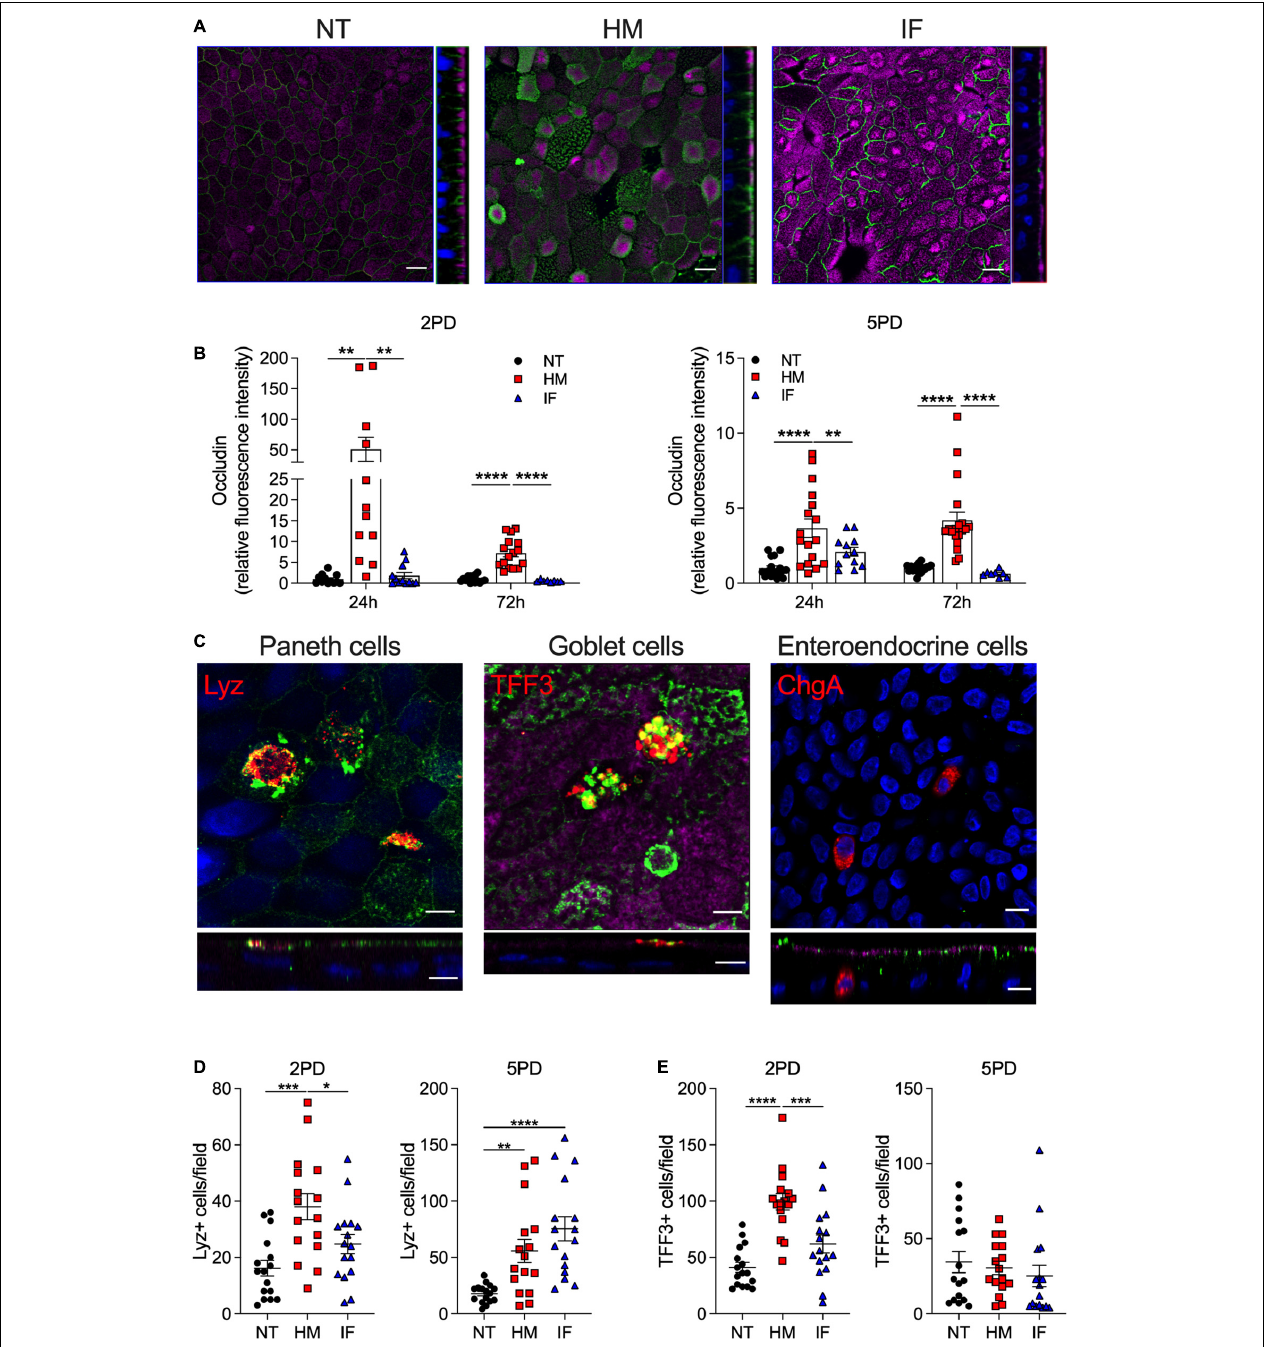
FIGURE 3 | Human milk modulates occludin expression. (A) Confocal microscopy images (XY and YZ projections) of 2PD enteroid monolayers NT or apically treated for 24 h with HM (20%; v/v) or IF (20%; w/v). Occludin, green; actin, magenta. Scale bar = 10 µ m. (B) Relative fluorescence intensity of occludin quantified by confocal microscopy analysis of monolayers treated with HM (20%; v/v) or IF (20%; w/v) for 24 and 72 h. Mean ± SEM are shown. Data represent three independents with n = 4–6 enteroid monolayers/group per experiment. Each symbol indicates an independent monolayer. p -values were calculated by one-way ANOVA with Šidák’s post hoc analysis. (C) Confocal microscopy images of 5PD enteroid monolayers treated with HM for 48 h. Occludin, green; lysozyme (Lyz), red; trefoil factor 3 (TFF3), red; chromogranin A (ChgA), red; actin, magenta; DNA, blue. Paneth and goblet cells, scale bar = 5 µ m; enteroendocrine cells, scale bar = 10 µ m. (A,C) Data are representative of three independent experiments with n = 3 enteroid monolayers/group per experiment. p -values were calculated by one-way ANOVA with Šidák’s post hoc analysis. (D) Number of Lyz-positive (E) and TFF3-positive cells quantified by immunofluorescent confocal microscopy analysis of monolayers treated with HM and IF as described in panel (A) . Data represent mean ± SEM of three combined experiments, each including four monolayers/group per experiment. Each symbol indicates an independent monolayer. p -values were calculated by one-way ANOVA with Tukey post hoc analysis. * P < 0.05; ** P < 0.01; *** P < 0.001; **** P <